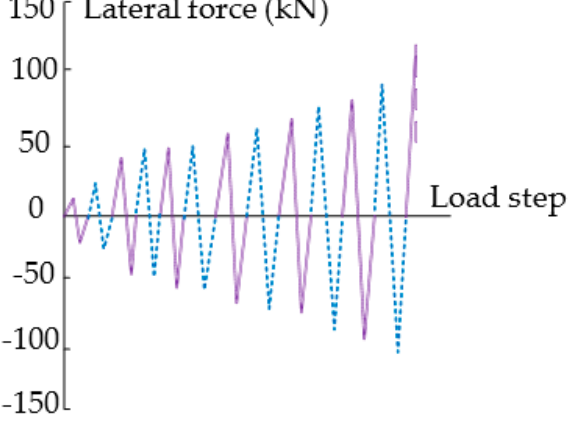
Figure 5. Lateral load cycles.